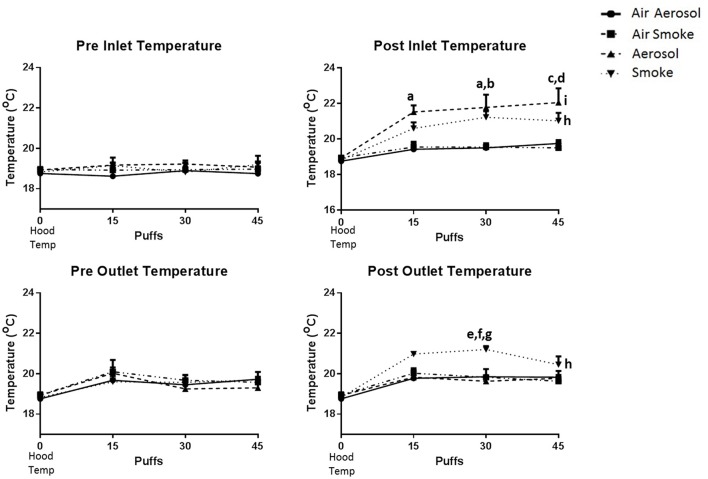
Temperatures within the laminar flow hood and within the inlet and outlet peristaltic pump tubing, before and after pumping air, ECIG-generated aerosol, and smoke. Data points given as mean ± standard error of the mean. Post-inlet between group comparisons; a = p < 0.05 at 15 and 30 puffs between aerosol and air through the aerosol pump, b = p < 0.05 at 30 puffs between aerosol and air through the smoke pump, c = p < 0.01 at 45 puffs between aerosol and air through the aerosol pump, and d = p < 0.01 at 45 puffs between aerosol and air through the smoke pump. Post-outlet between group comparisons at 30 puffs; e = p < 0.05 between smoke and air through the aerosol pump, f = p < 0.05 between smoke and air through the smoke pump and g = p < 0.01 between smoke and aerosol. Within group comparisons between hood temperature (control) and exposure to smoke (h = p < 0.05) or aerosol (i = p < 0.05).